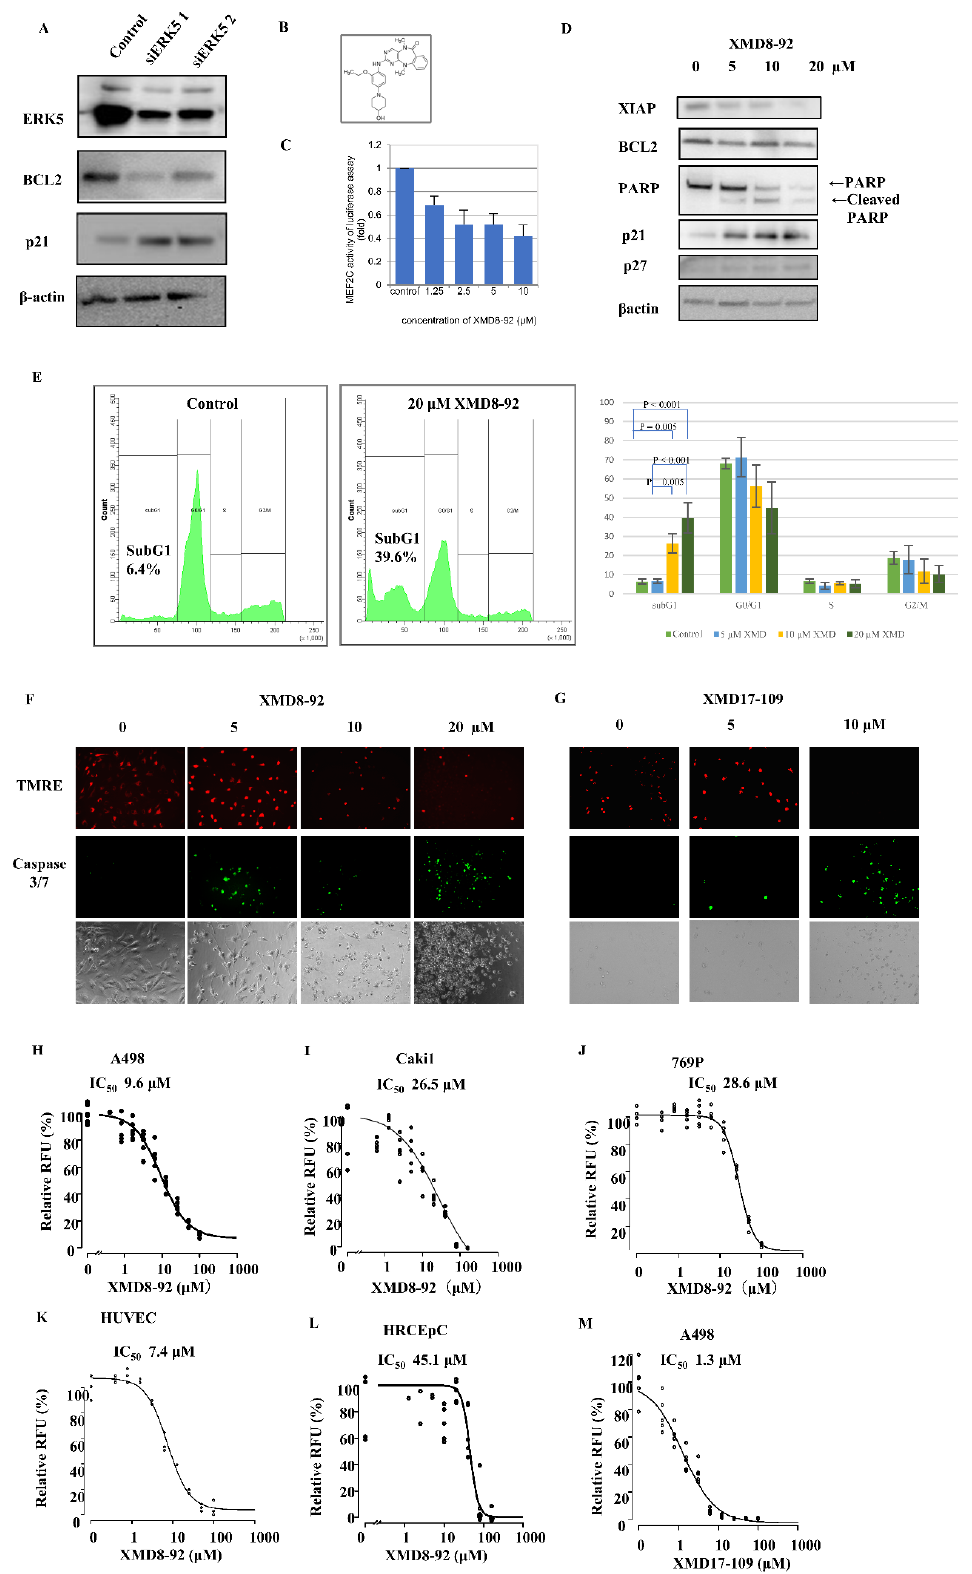
Figure 3. Effects of ERK5 inhibition. ( A ) Transient knockdown of ERK5 inhibited BCL2 and enhanced p21 on Western blotting in A498 cells. ( B ) The structure of ERK5 inhibitor XMD8-92. The error bars indicate standard deviation. ( C ) XMD8-92 suppressed the expression of MEF2C, ERK5, down-stream protein in a dose-dependent manner on luciferase-reporter assays in A498 cells. ( D ) XMD8-92 suppressed anti-apoptotic protein BCL2, produced cleaved PARP, and enhanced p21 and